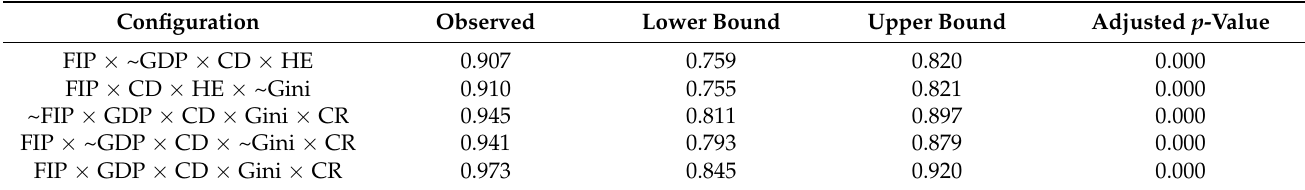
Table 7. Consistency for high energy consumption efficiency performance.